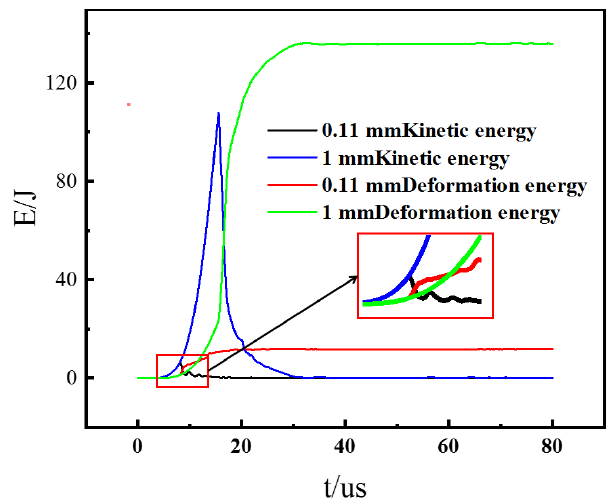
Figure 22. Variation of pipe energy during deformation under different gaps of 6 kV discharge volt-